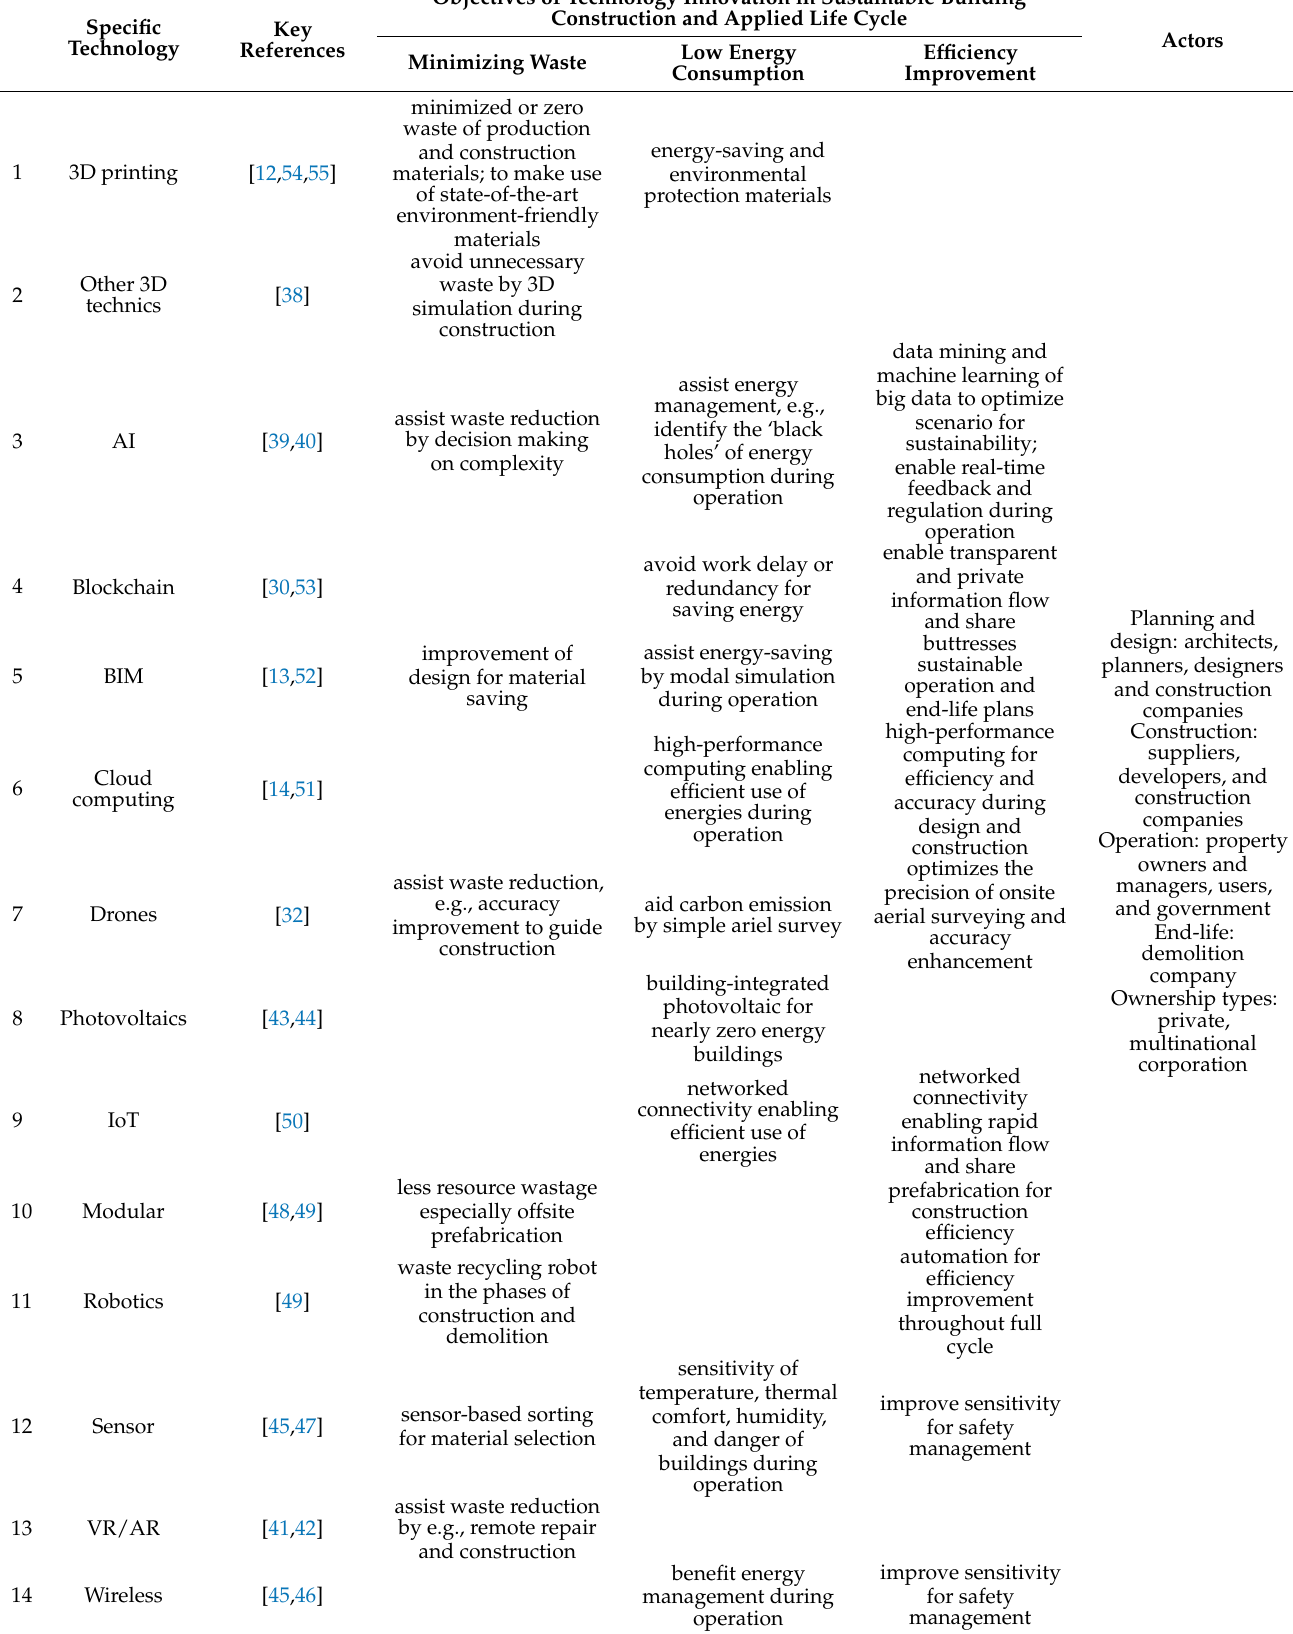
Table 1. Conceptual framework of innovative potential and actors of technologies for sustainable building